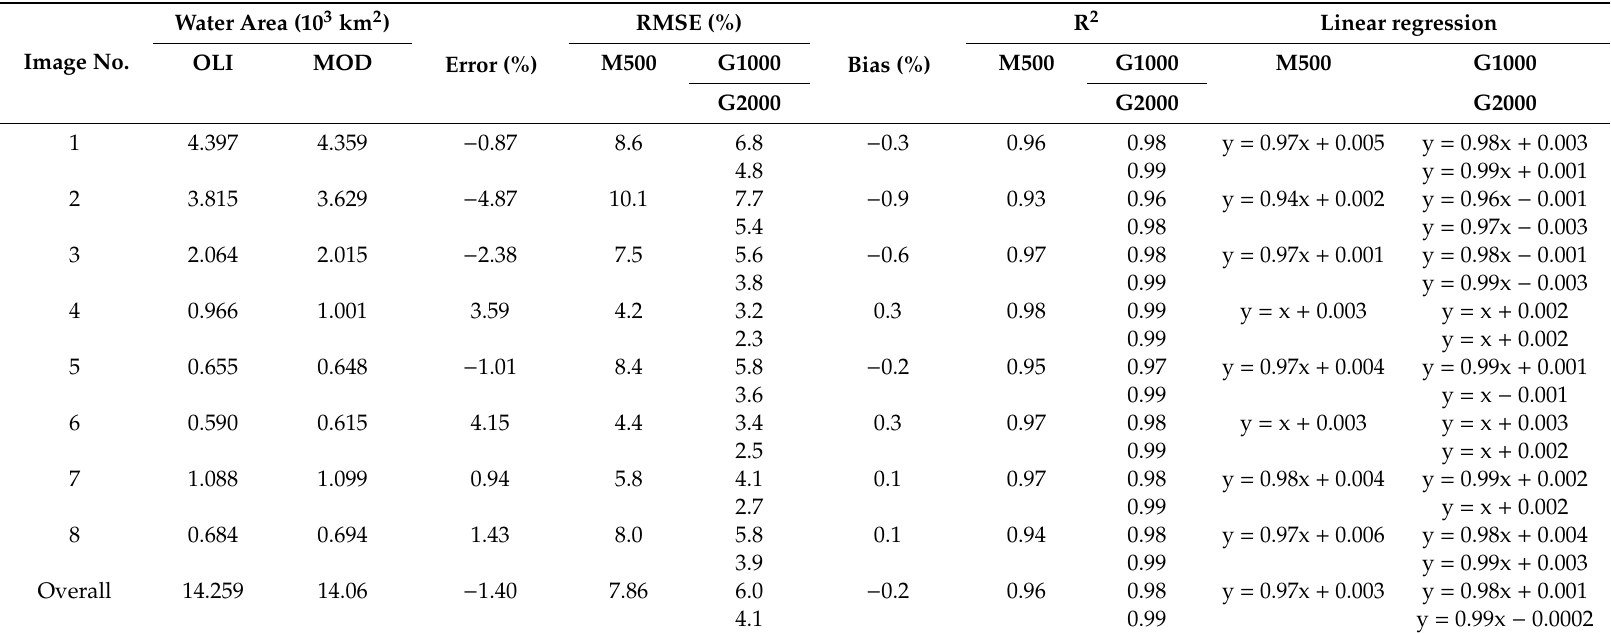
Table 4. Comparison of Landsat and MODIS derived water